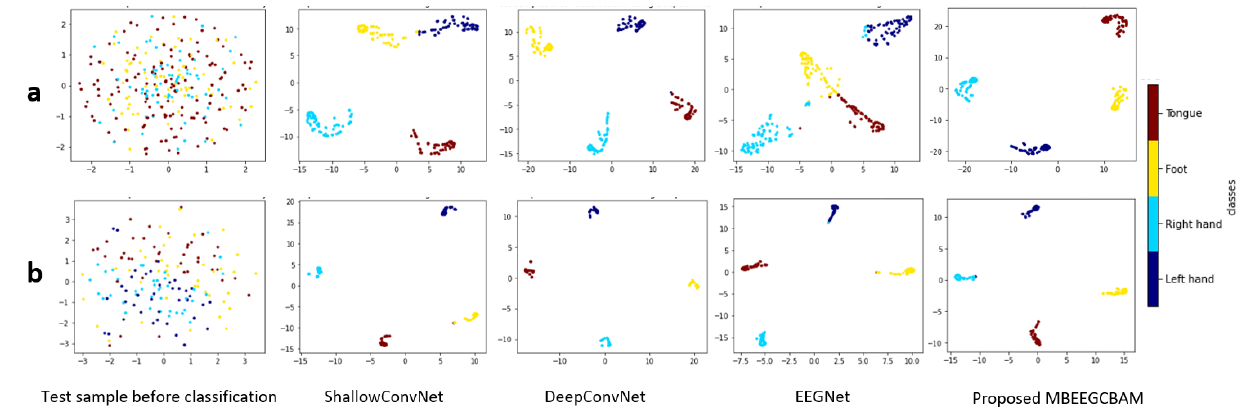
Figure 11. The t-SNE visualization of test sample features before and after classification using the comparative methods in the third subject in ( a ) the BCI-IV2a, and ( b ) the